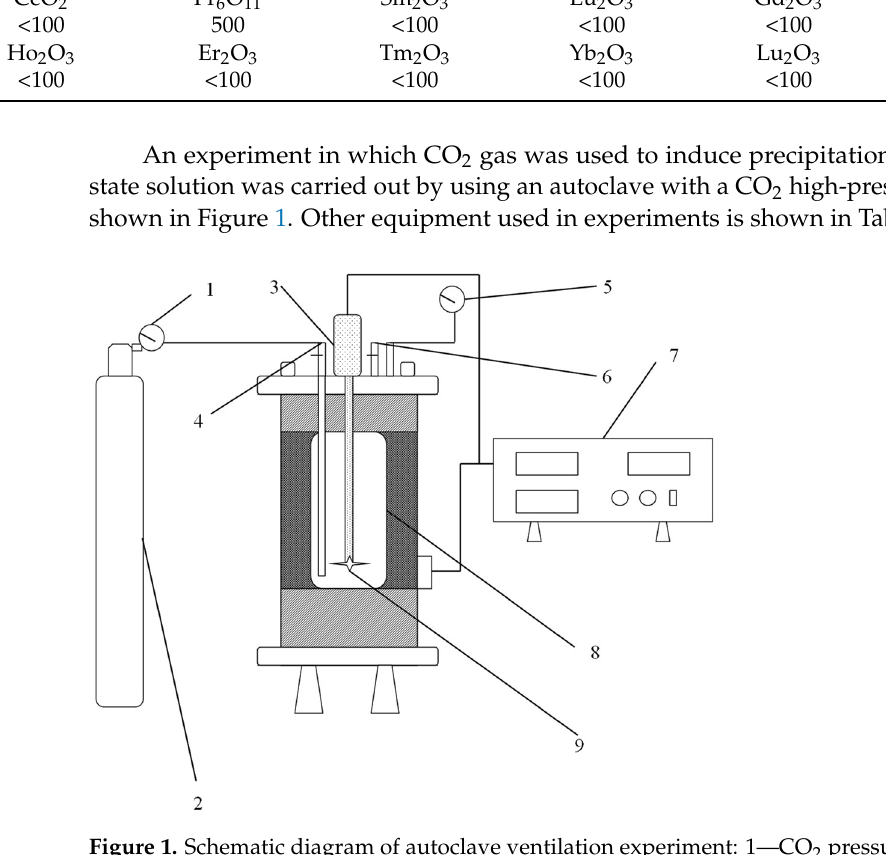
Figure 1. Schematic diagram of autoclave ventilation experiment: 1—CO 2 pressure reducing valve; 2—high pressure cylinder; 3—rotating motor; 4—air inlet; 5—safety valve; 6—air outlet; 7—controller; 8—polytetrafluoroethylene tank; 9—agitator.